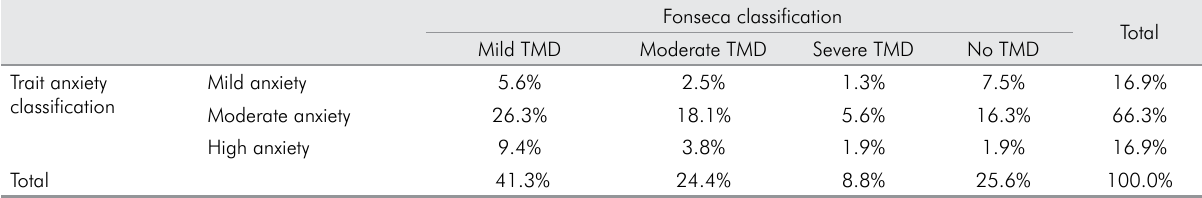
Table 2. Association between the Fonseca classification and trait anxiety